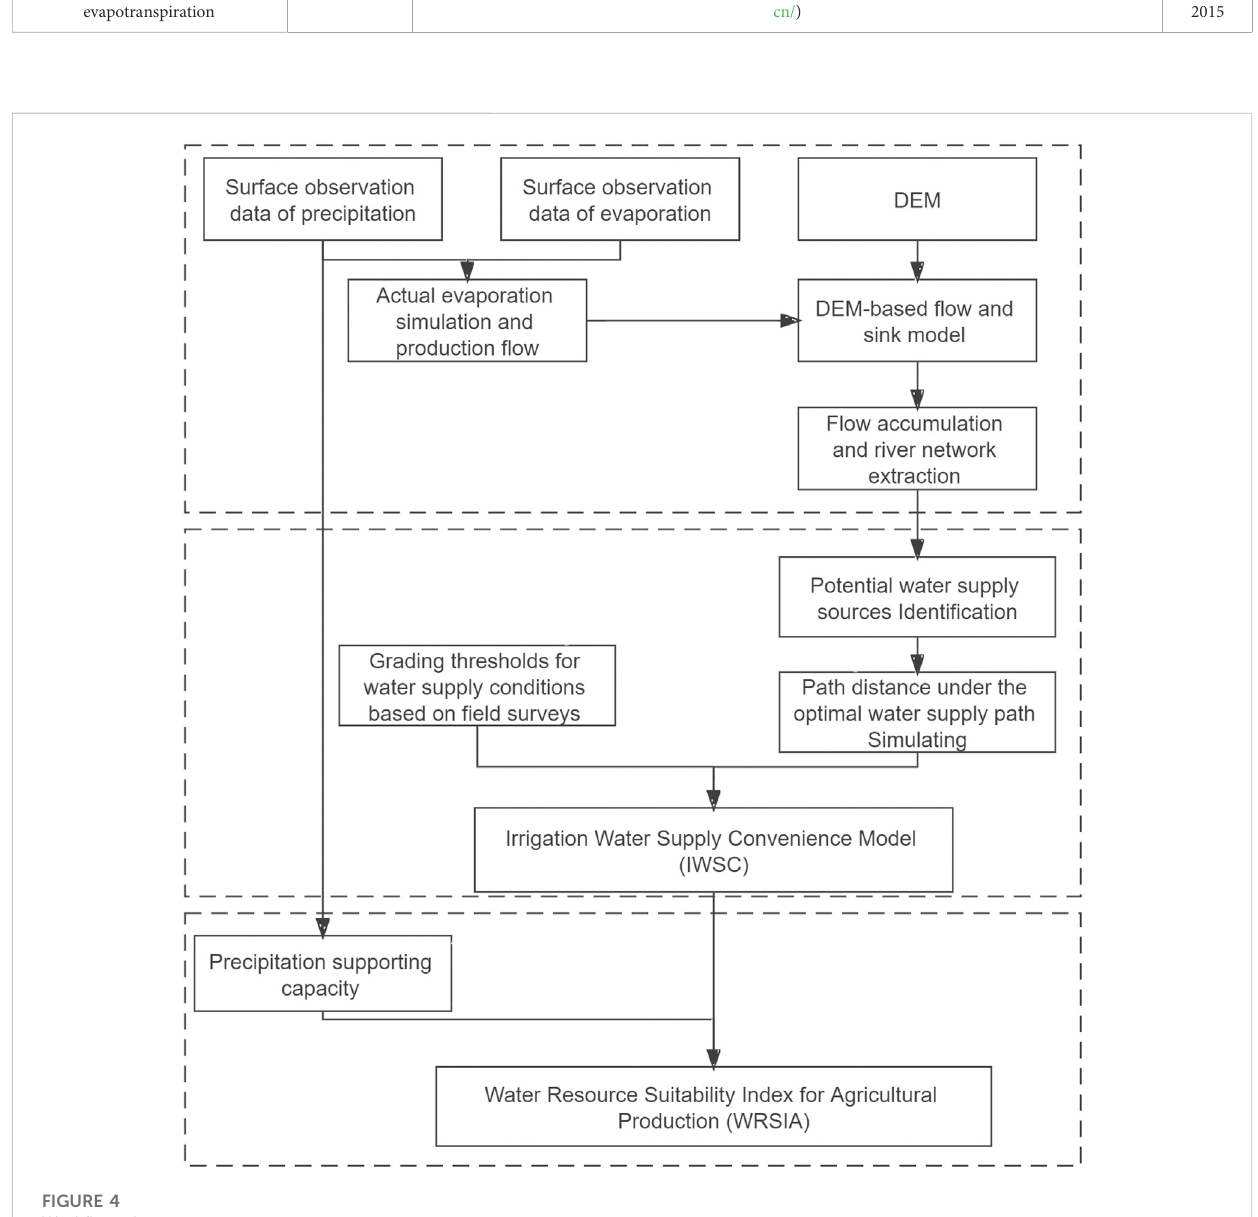
FIGURE 4 Work fl ow